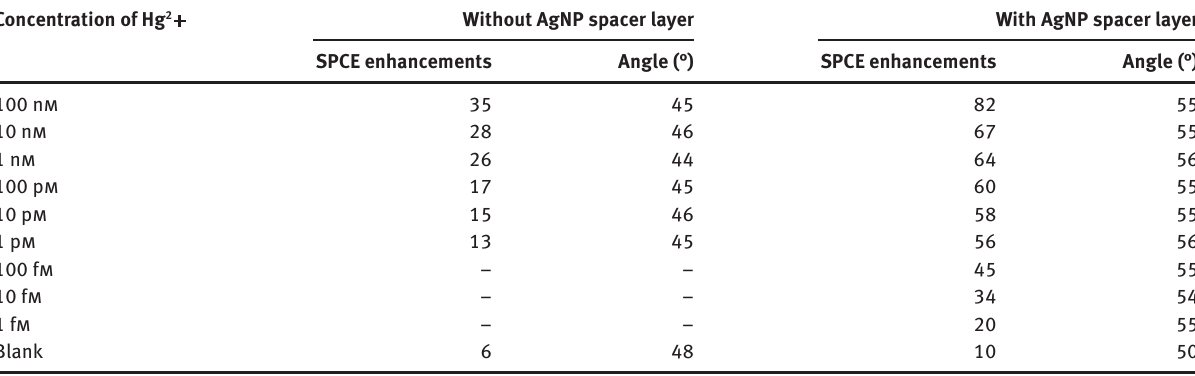
Table 1: SPCE enhancements and angularity obtained for different Hg 2 + concentrations using Rh6G D (with and without an AgNP spacer layer). Concentration of Hg 2